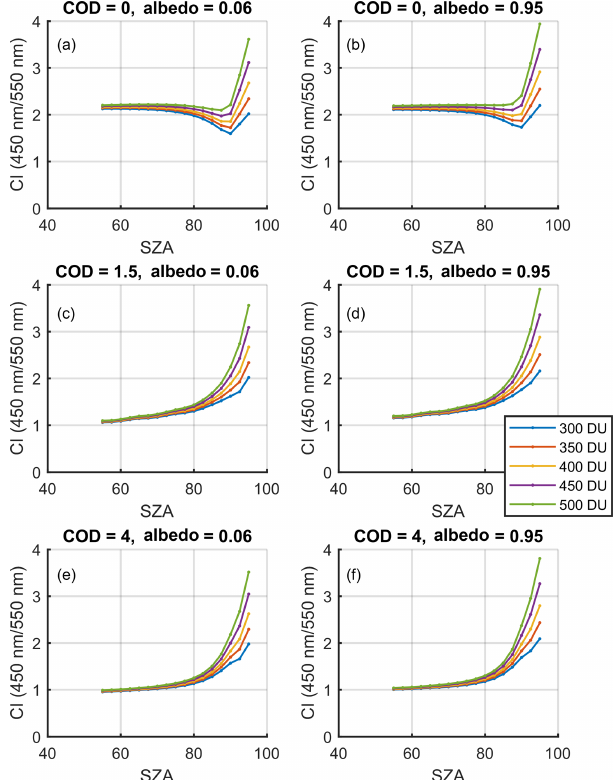
Figure A1. Simulated colour index with different total column ozone and surface albedo values. The cloud optical depth and sur- face albedo values are indicated on each panel. Simulations with different total column ozone values are indicated by the different colour lines, as labelled in the